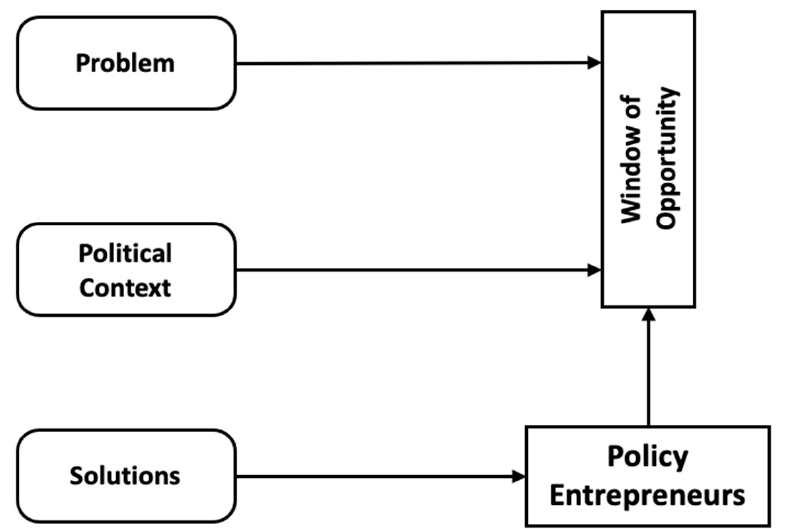
Figure 2. Visual representation of Kingdon’s Multiple Streams Framework. Source: Zahariadis, in Sabatier, 2007 [30].